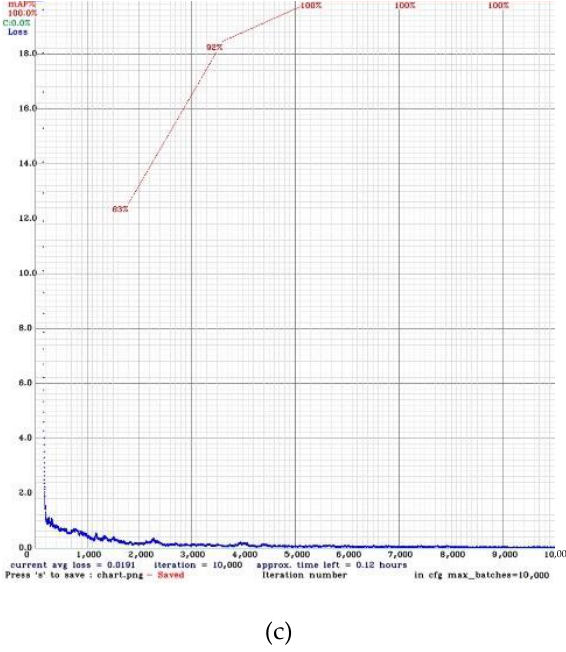
Figure 12. Training models. ( a ) person detection model ( b ) 30 items detection model ( c ) stacking and height occlusion detection model. Table 3. The results of YOLO v4 model.